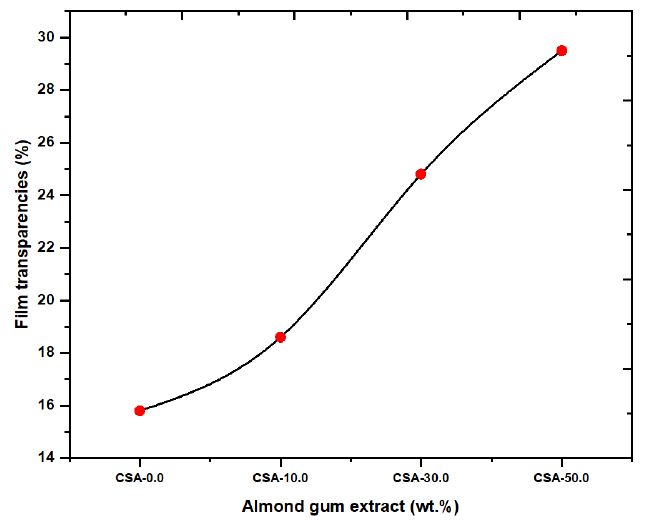
Figure 6. Film transparency versus film type.